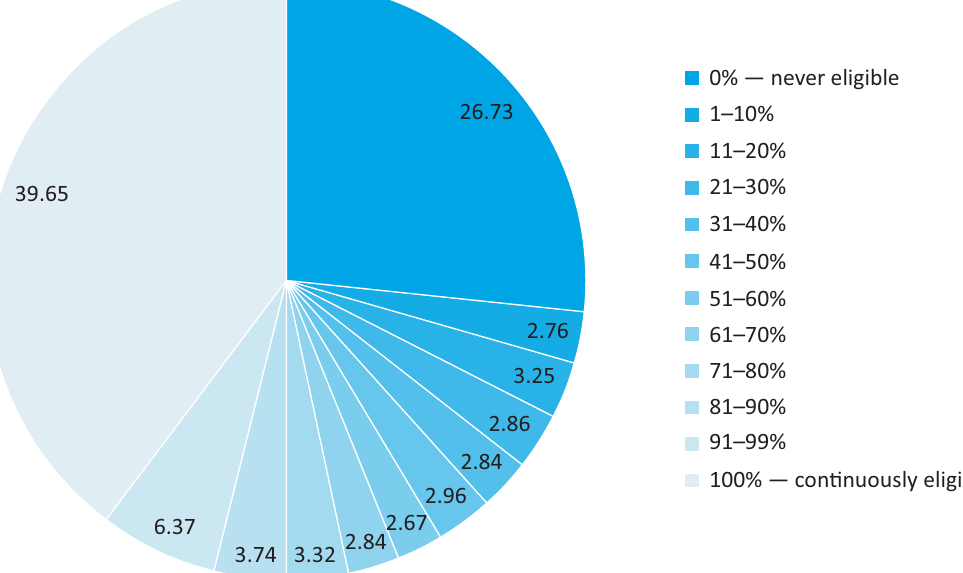
Figure 1. Distribution of the eligibility indicator 2000–2010 (proportion of time mothers were eligible for parental leave over the observation window; N = 15,893). Source: BASD‐Panel, calculations by the authors. of which only 24% never meets the eligibility